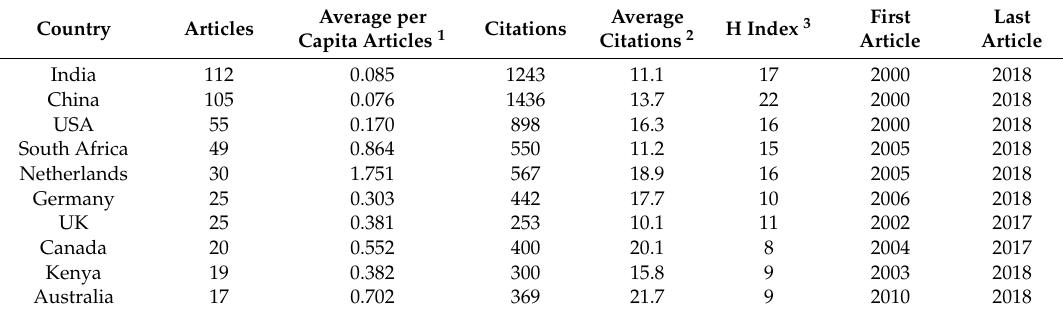
Table 3. Main characteristics of the most active countries related to RWHI